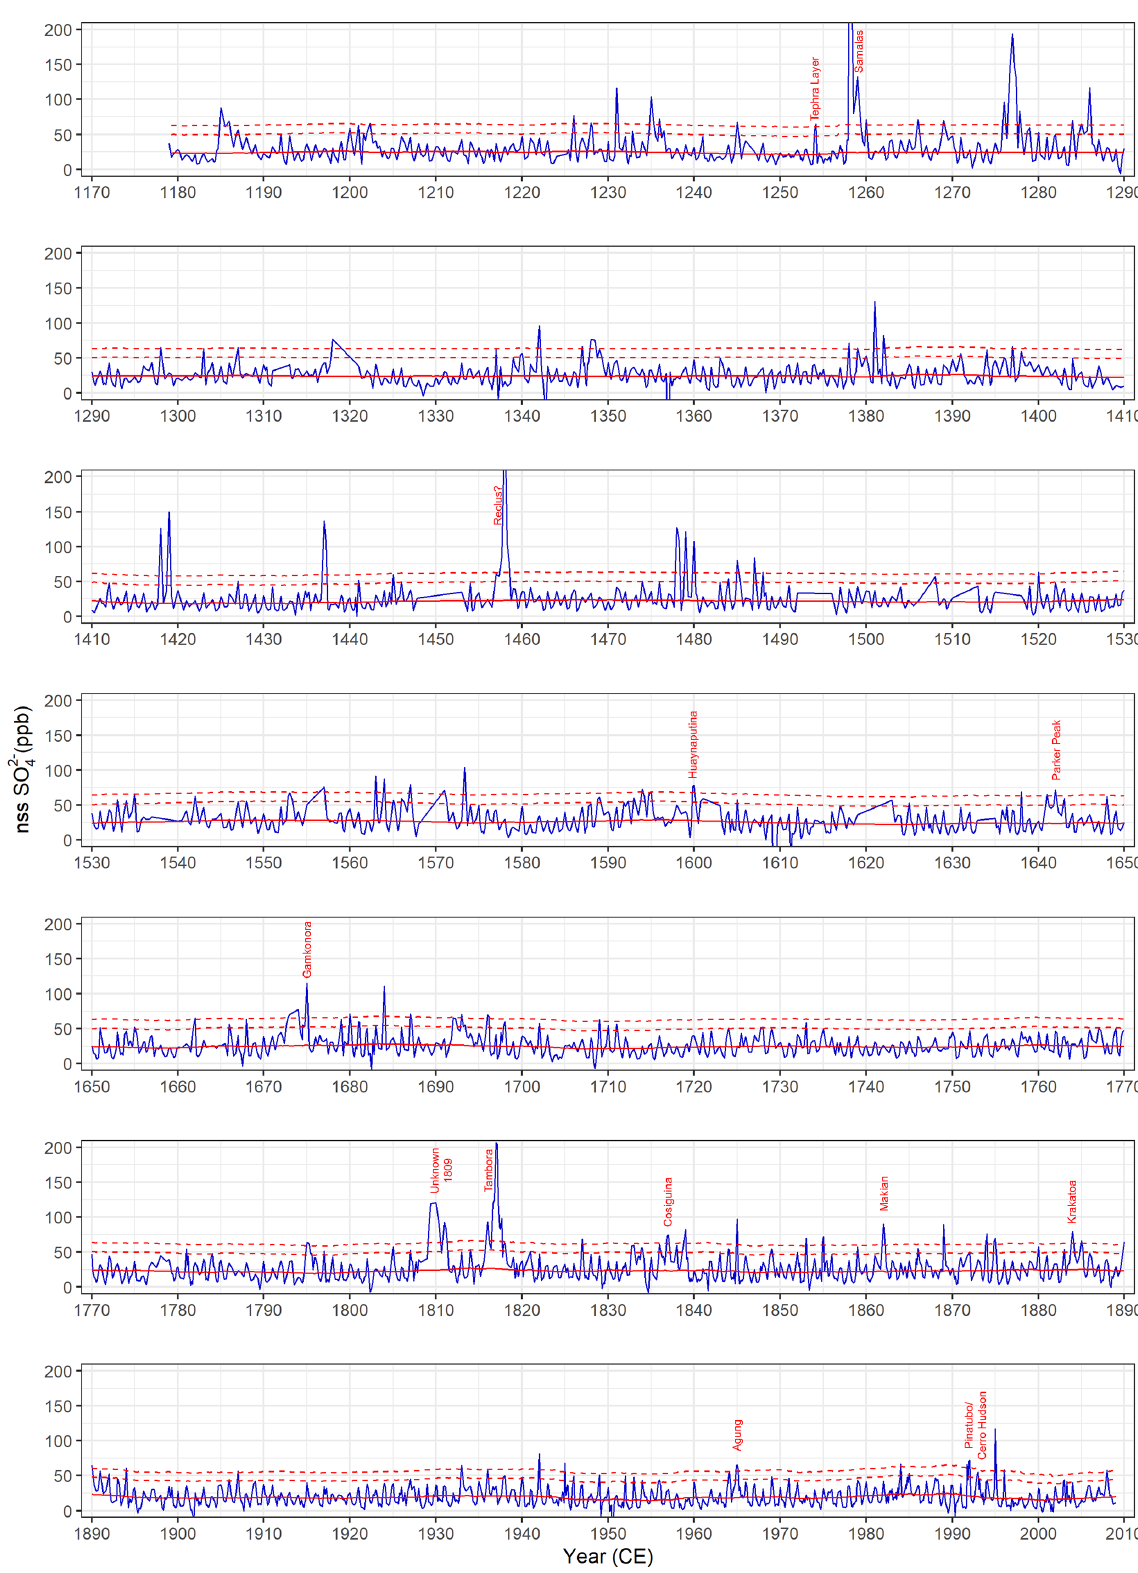
− profile plotted on the age scale produced in this paper. Biogenic background (solid red) and thresholds used to Figure 4. GV7(B) nssSO 2 4 identify the volcanic signatures (2 σ and 3 σ , dashed red) are also